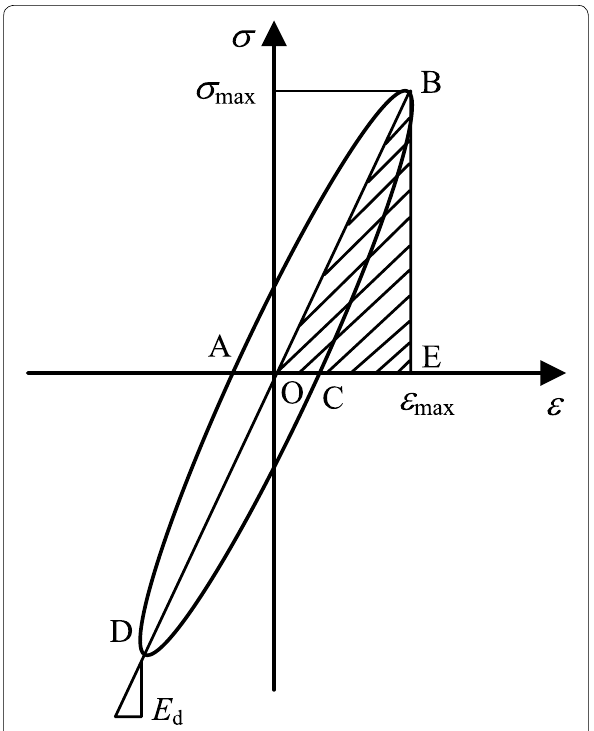
Fig. 5 Sketch of hysteresis loop.